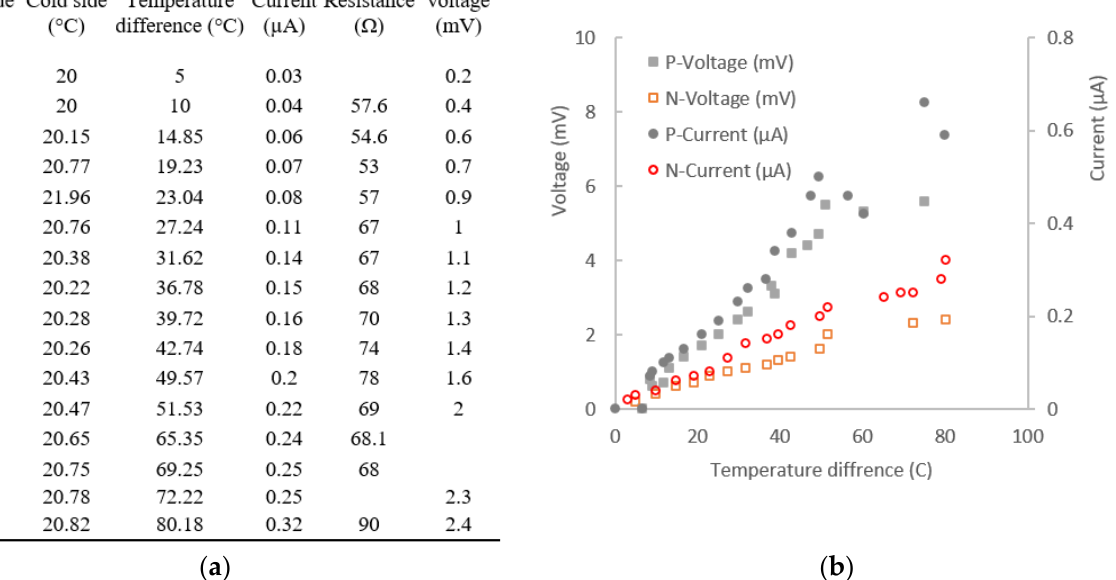
Figure 8. The output of thin film for both P-type (P4-G) and N-type (N4-G) layer on glass slide: ( a ) detail of the temperature change and related power output and resistance change; ( b ) the change of open circuit voltage and current against temperature